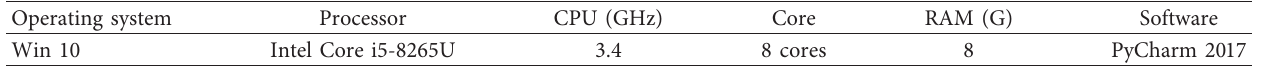
Table 1: Experimental environment configuration.